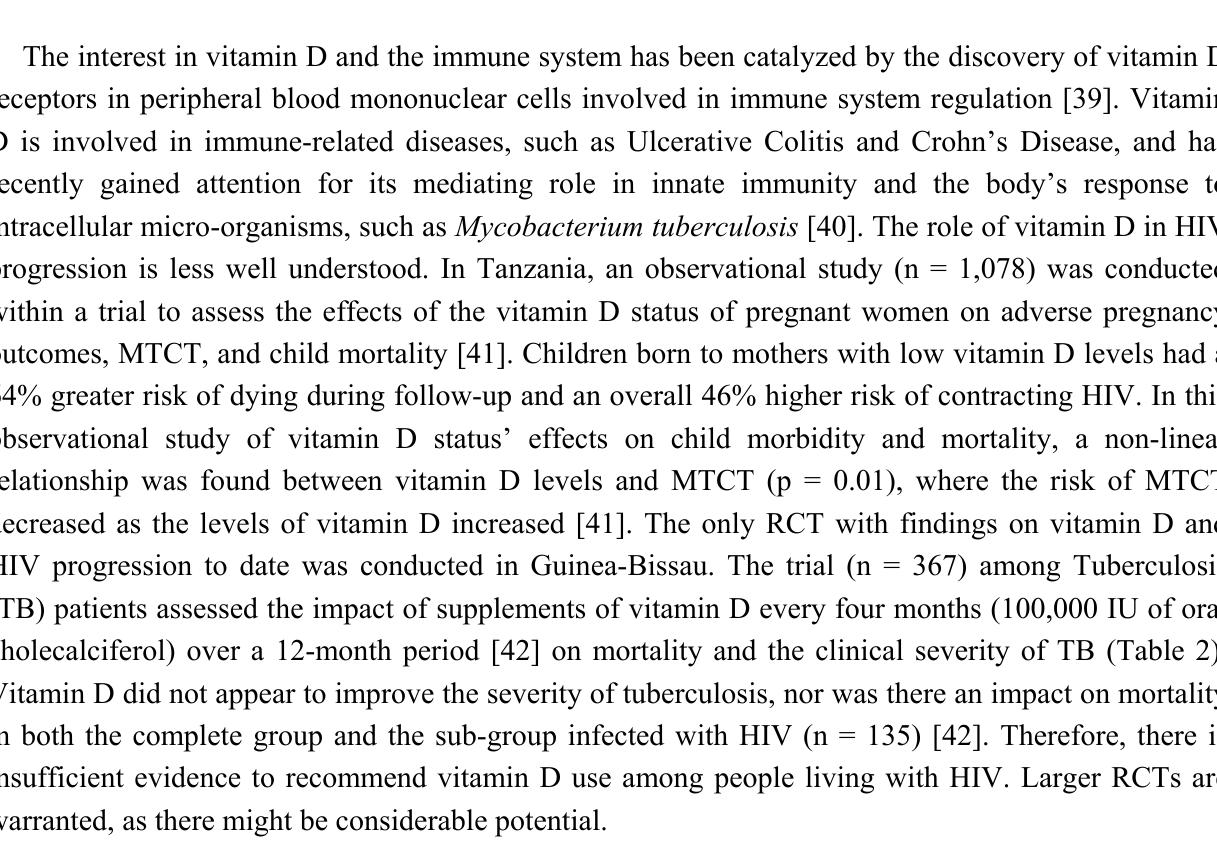
Table 2. Randomized controlled trials on vitamin B, C, D, E and folic acid, and HIV